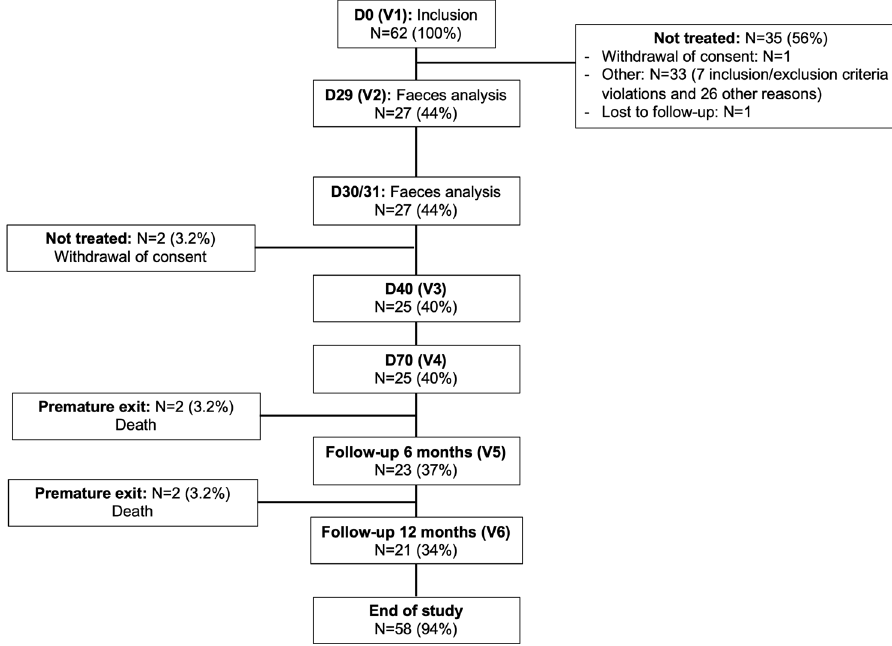
Fig. 7 CONSORT diagram. AFMT is for autologous fecal microbiota transfer; D, day; N, number of patients, V1 to V6, visit 1 to visit